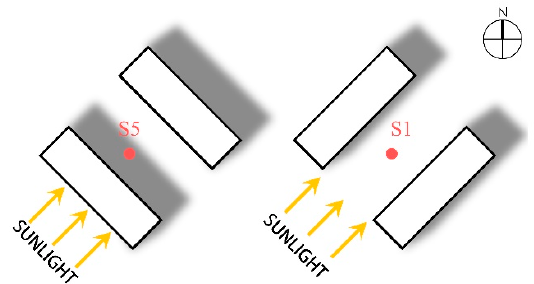
Figure 2. Monitoring sites of streets with different orientation.